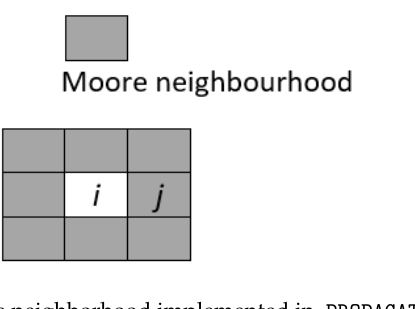
Figure 5. Moore neighborhood implemented in PROPAGATOR